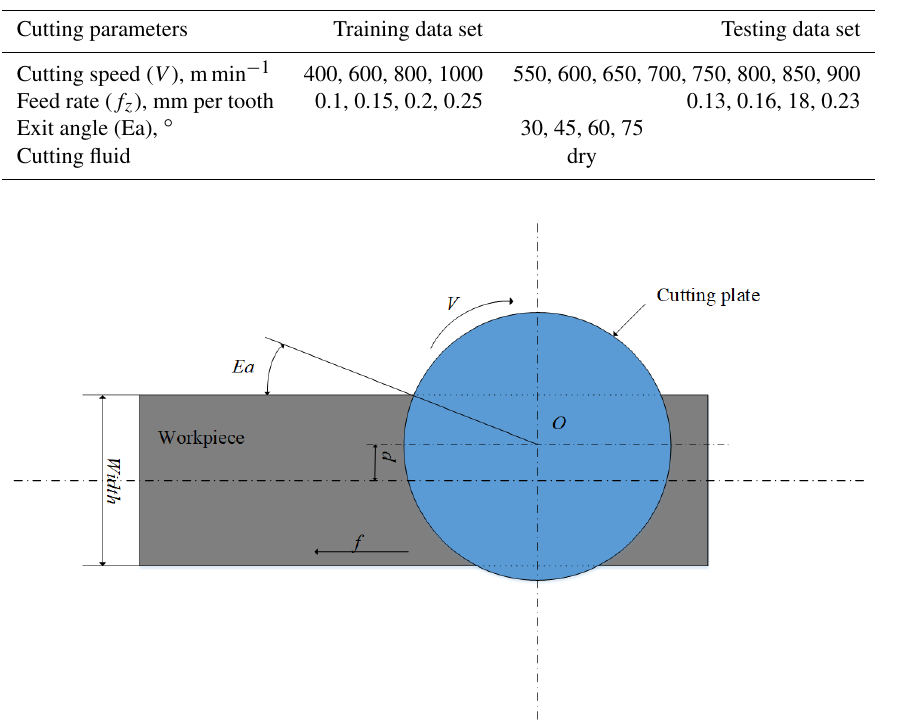
Table 2. Milling conditions in high speed cutting.